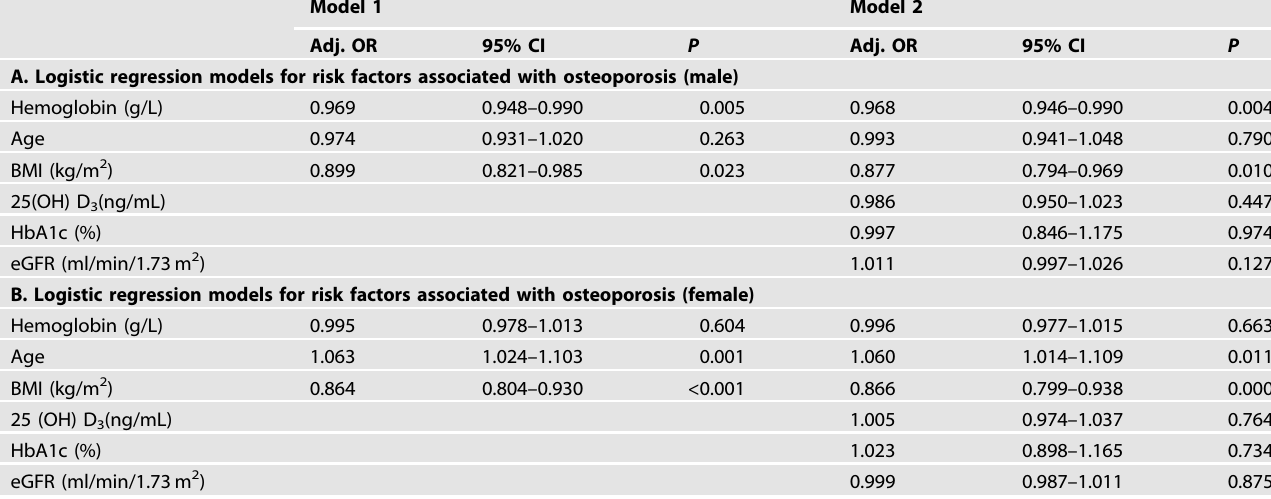
Table 3. Logistic regression models for risk factors associated with osteoporosis for both